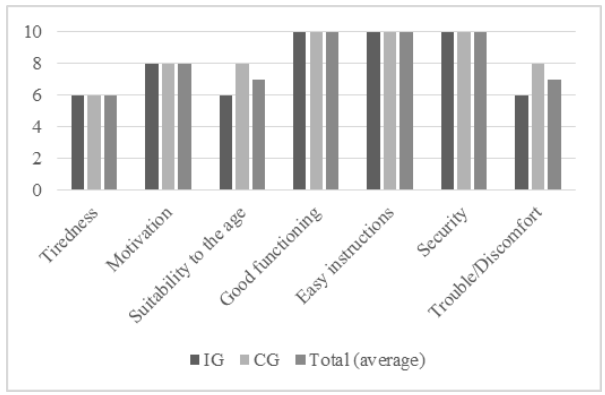
Fig. 1. Positive responses to the game evaluation